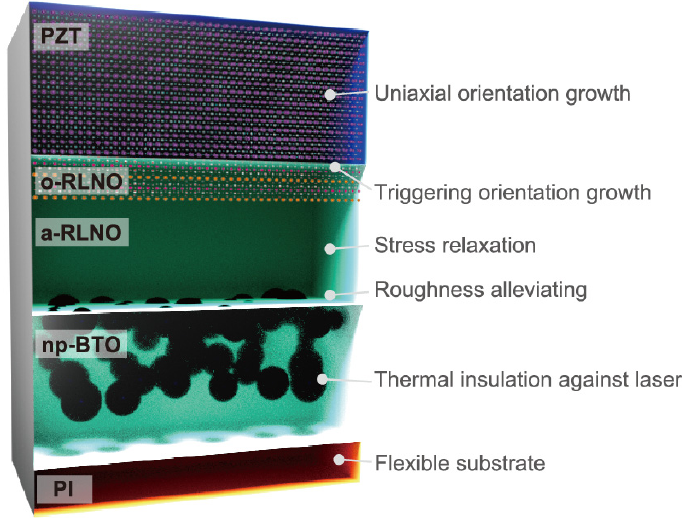
Figure 9. Schematic illustration of the PZT/RLNO/BTO/PI layer structure with the role of each layer. o-, a-, and np- represent “oriented”, “amorphous”, and “nanoparticle-derived”,